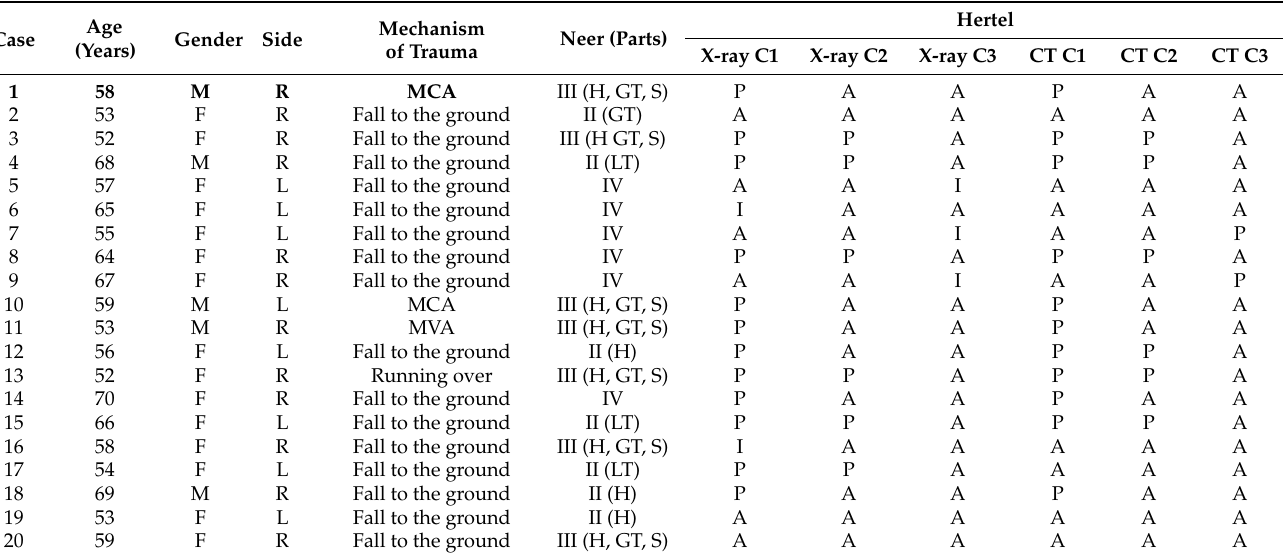
Table 1. Patient demographics and STANDARD assessment ( n =